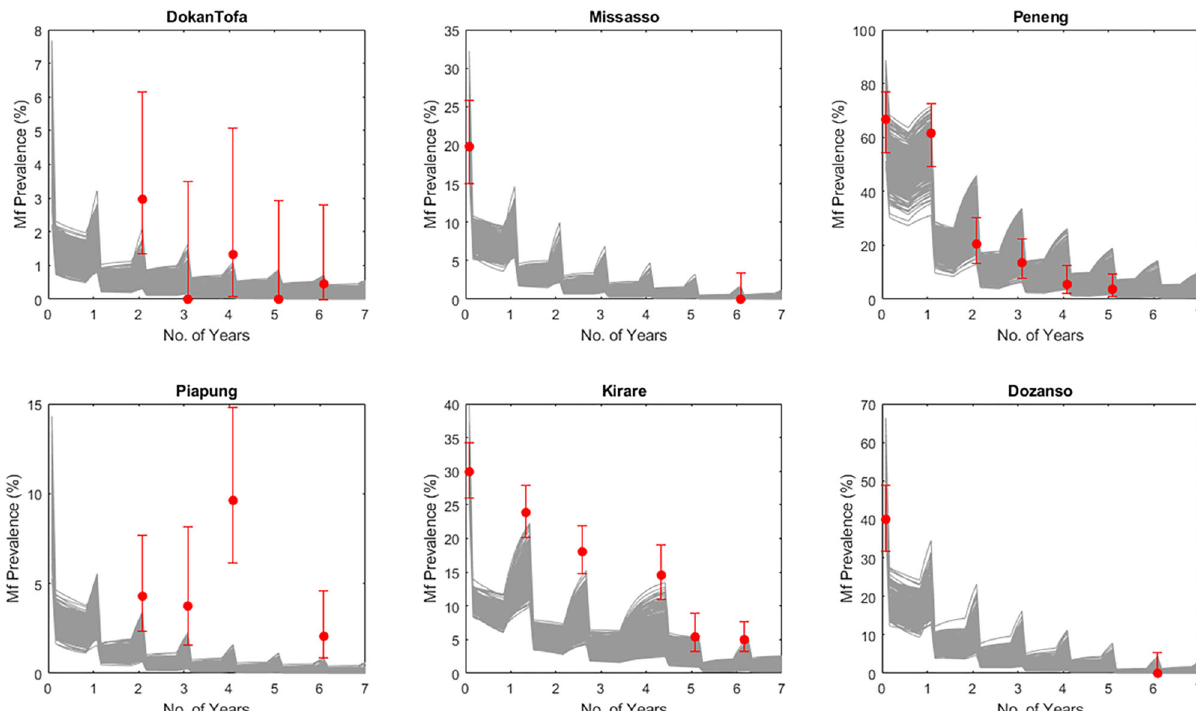
Fig. 2 Forecasting impacts of the MDAs carried out in each site on changes in mf prevalence for two low-prevalence sites (DokanTofa and Piapung), two medium-prevalence sites (Missasso and Kirare), and two high-prevalence sites (Peneng and Dozanso). Red circles indicate the observed data and gray lines indicate the model predictions. The overall Monte Carlo p-values for the fi ts of post-MDA data for the six study sites were evaluated and indicated good fi ts in all sites (provided in Supplementary Table 3 in Supplementary Information). Error bars indicate the 95% con fi dence intervals of the data